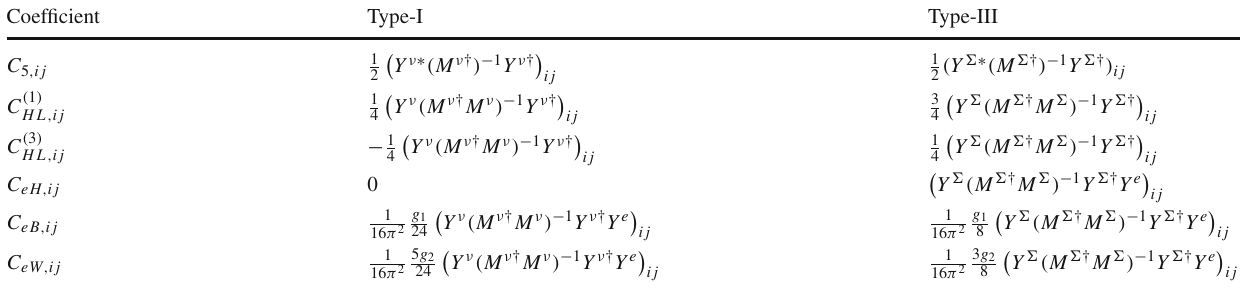
lepton flavour violation, the electroweak dipole operators C eB and C eW (last two rows) are matched to one-loop order, while all other operators are matched at tree level